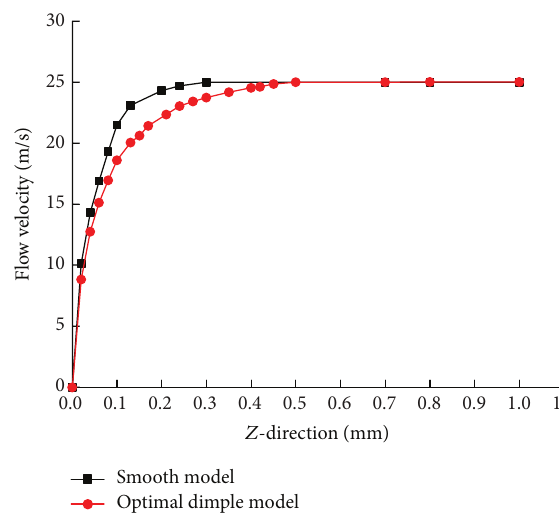
Figure 11: Comparison of velocity gradient.